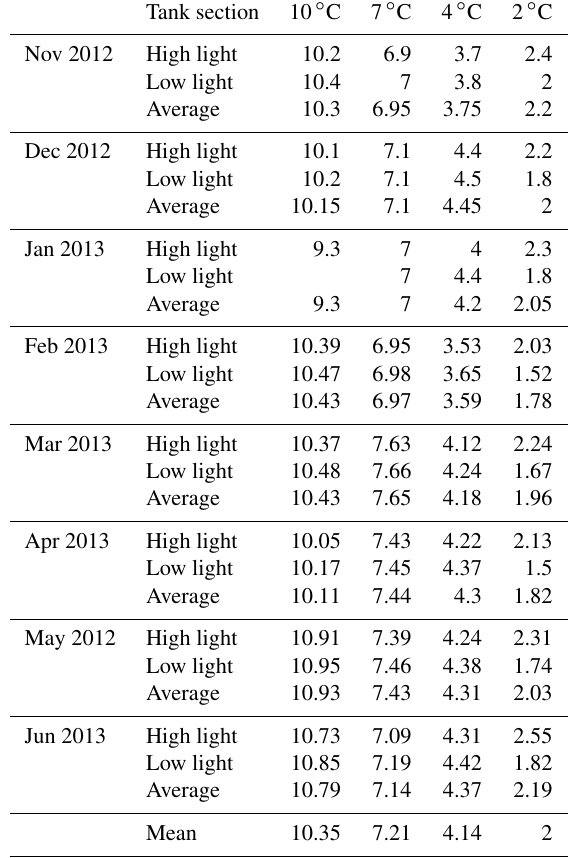
Table 1. Average tank temperatures, November 2012–June